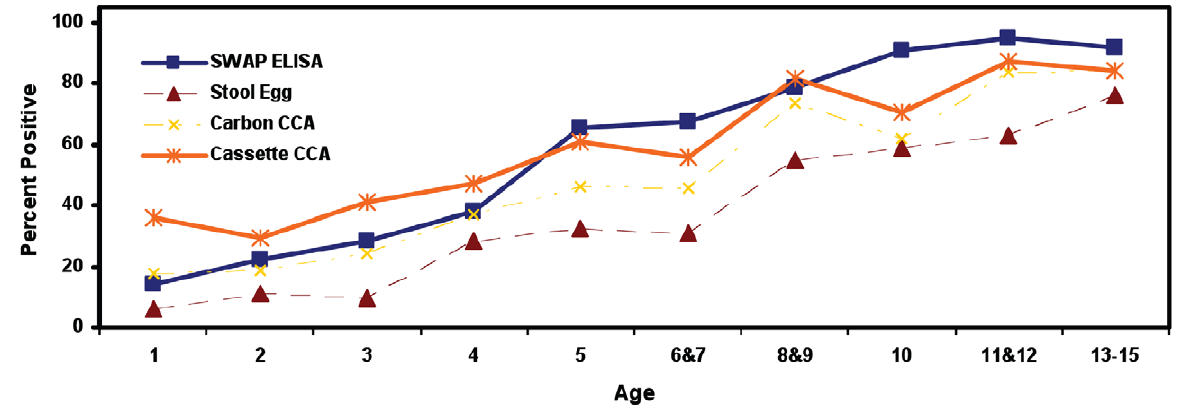
Figure 1. Prevalence of schistosome positive individuals by age. Prevalence increases with age for all 4 assays.